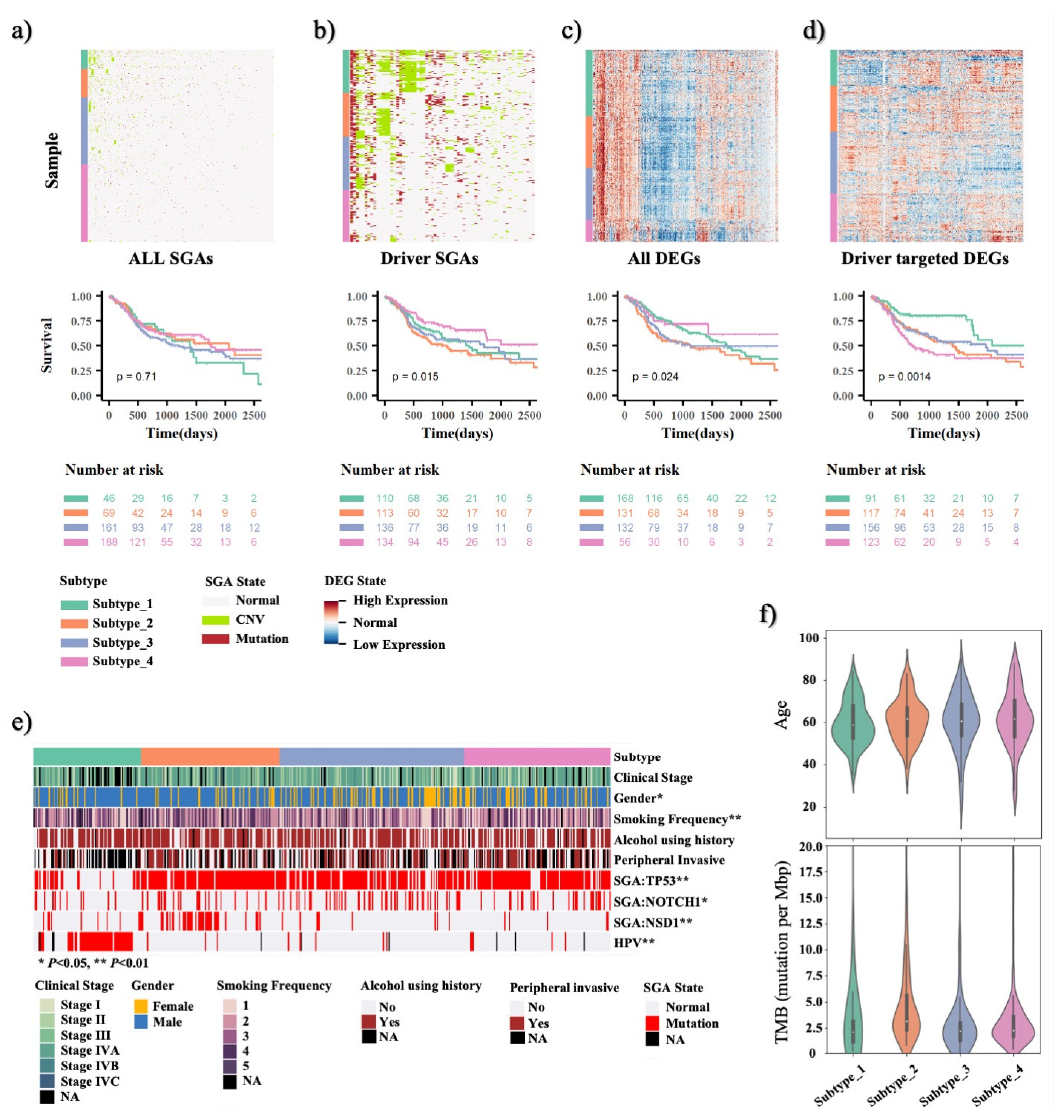
Figure 3. Molecular subtyping of HNSCC tumors using TCI-derived features. The subtypes of HNSCC patients are classified using hierarchical clustering and then studied using survival analysis using ( a ) all 17,646 SGA states, ( b ) 64 TCI SGA states, ( c ). all 10,120 gene expression levels and ( d ) 903 TCI-inferred DEG expression levelss, respectively. The colors of the side bar of the heatmap represent the subtype. Survival times are constrained to 2500 days. Survival analysis is carried out to calculated p value for patient groups categorized using different datasets. ( e ). Statistical association of clinical features with 4 HNSCC patient subtypes categorized using 903 TCI DEGs. NA in the legend represents missing values. ( f ). Violin plot of age and tumor mutation burden (TMB) distributions in 4 HNSCC patient subtypes categorized using 903 TCI DEGs.